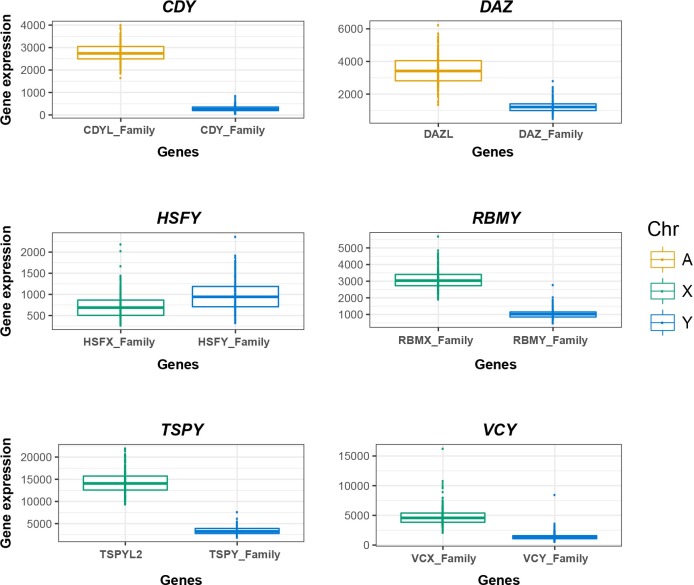
Expression differences between Y ampliconic genes and their non-Y homologs.Each plot compares expression levels of Y ampliconic gene family (the sum of expression of all copies of a gene family, blue) to their homologs on the X chromosome (green) or autosomes (yellow). The gene names are shown on the x-axis and normalized expression levels—on the y-axis.